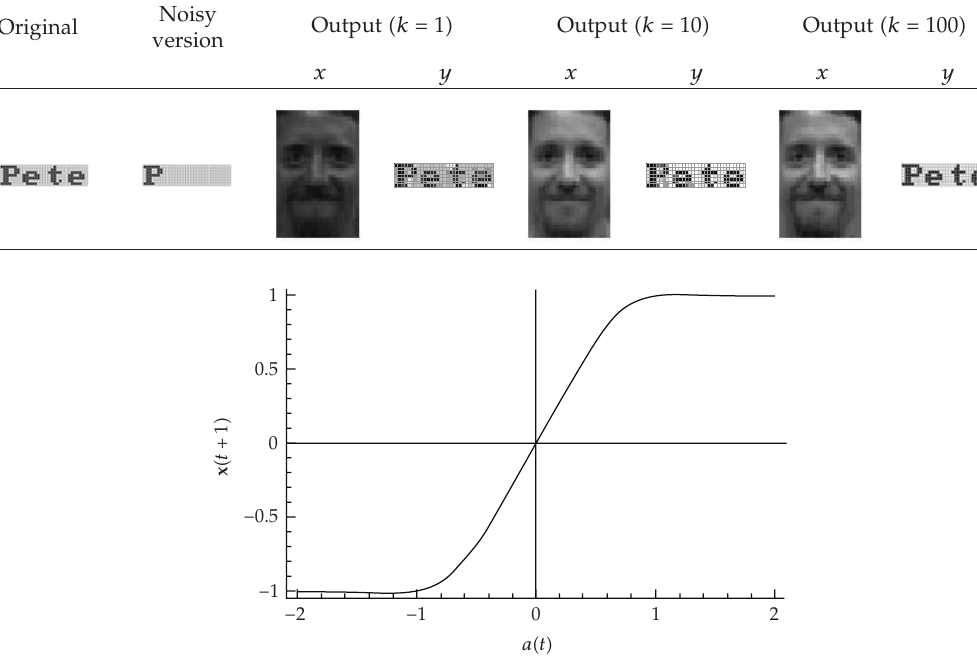
Figure 13: Transmission function when δ (cid:8) 0.5 with hard limits at − 1 and (cid:9)